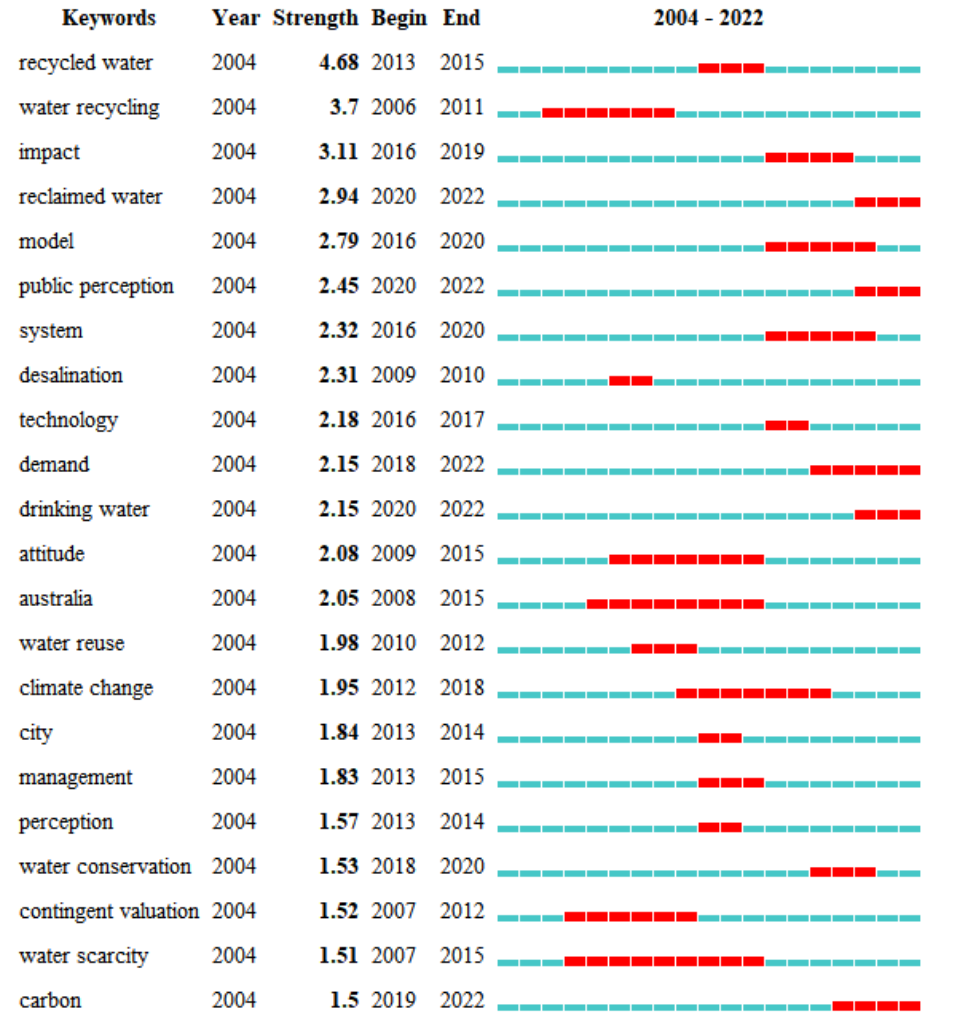
Figure 15. Keyword bursts in research on reclaimed water utilization policy from WOS.